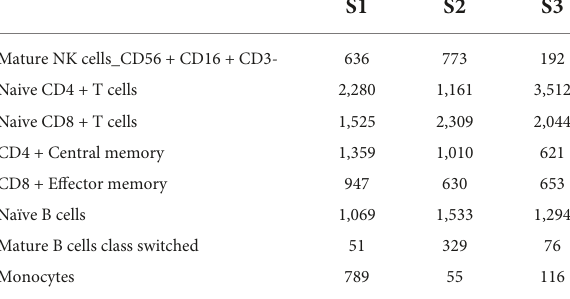
TABLE 3 The cell number of main